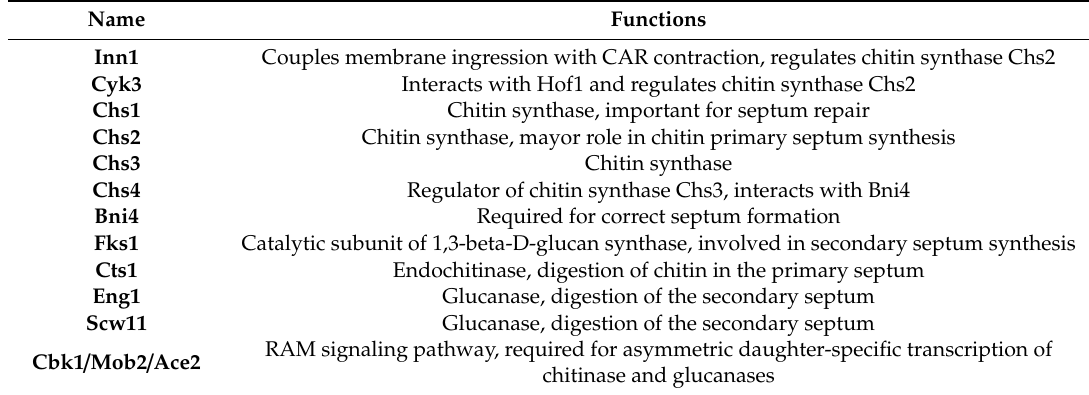
Table 2. Budding yeast proteins that are involved in the final steps of cytokinesis.